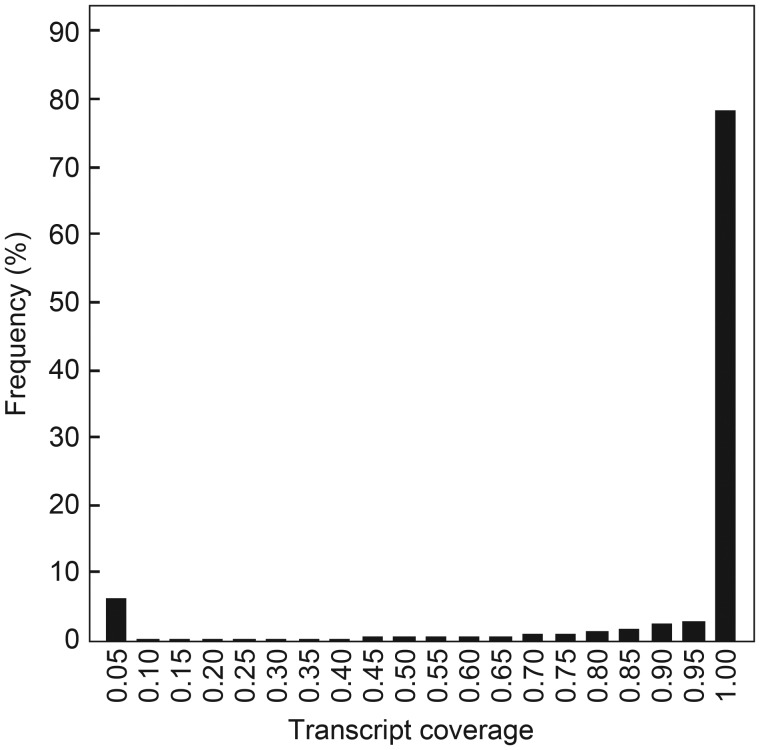
Nipponbare transcripts covered by Kasalath pseudomolecule sequences. The horizontal axis represents the sequence coverage (×100%) of each gene annotated on Nipponbare pseudomolecules.